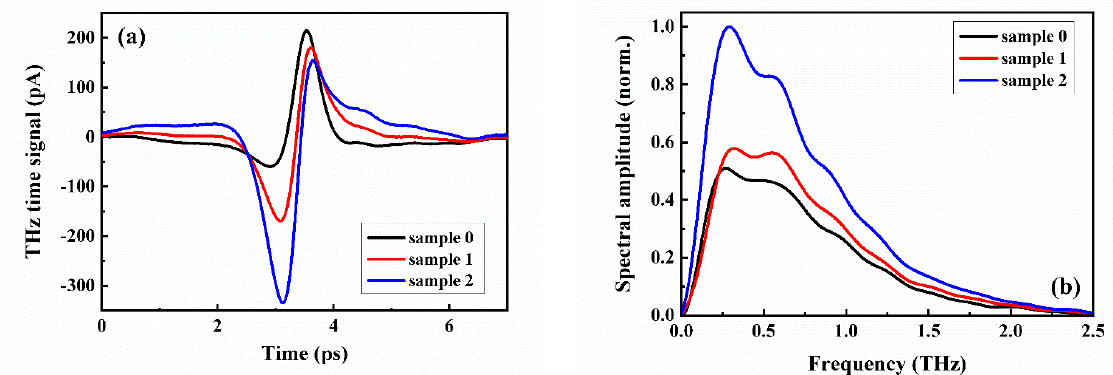
Figure 2. ( a ) Radiated THz waveforms of copper indium gallium diselenide (CIGS) thin films in time domain and ( b ) frequency domain waveforms of time-domain waveforms of CIGS thin films through fast Fourier transformation.